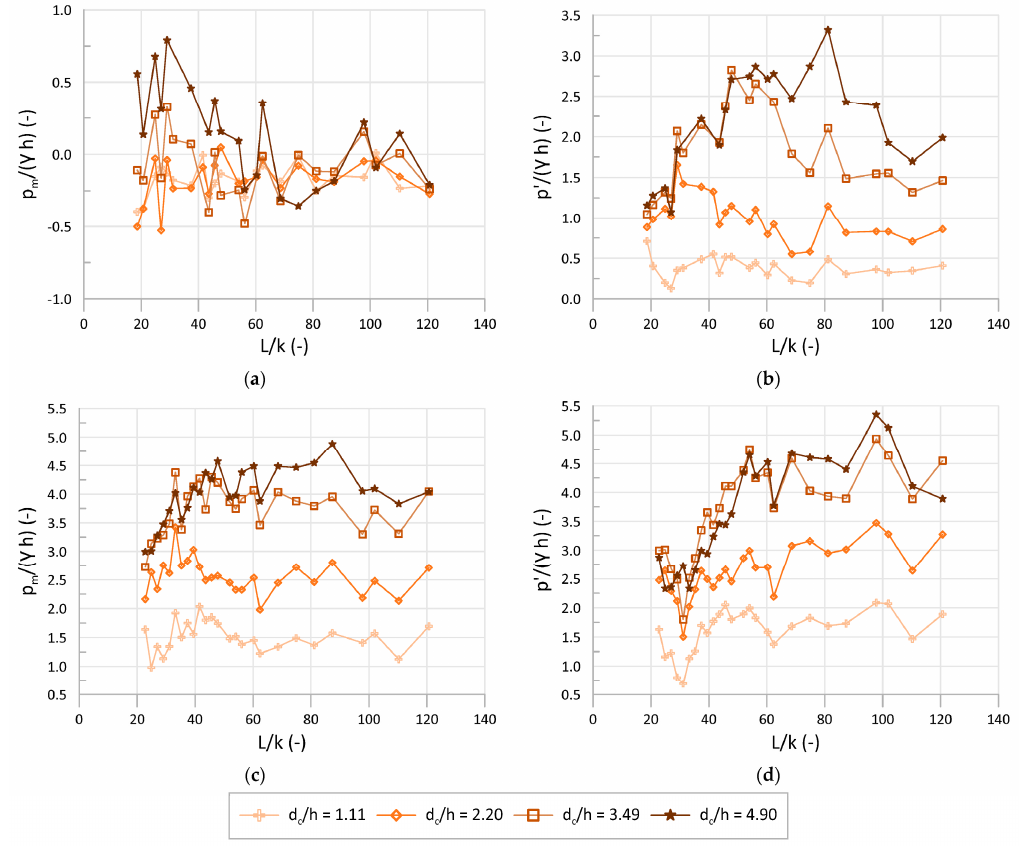
Figure 5. Streamwise development of the dimensionless mean (left) and fluctuating (right) pressures at the LOH II stepped chute: ( a , b ) vertical face of the step, near the outer edge (z/h = 0.133); ( c , d ) horizontal face of the step, near the outer edge (y/l = 0.178).